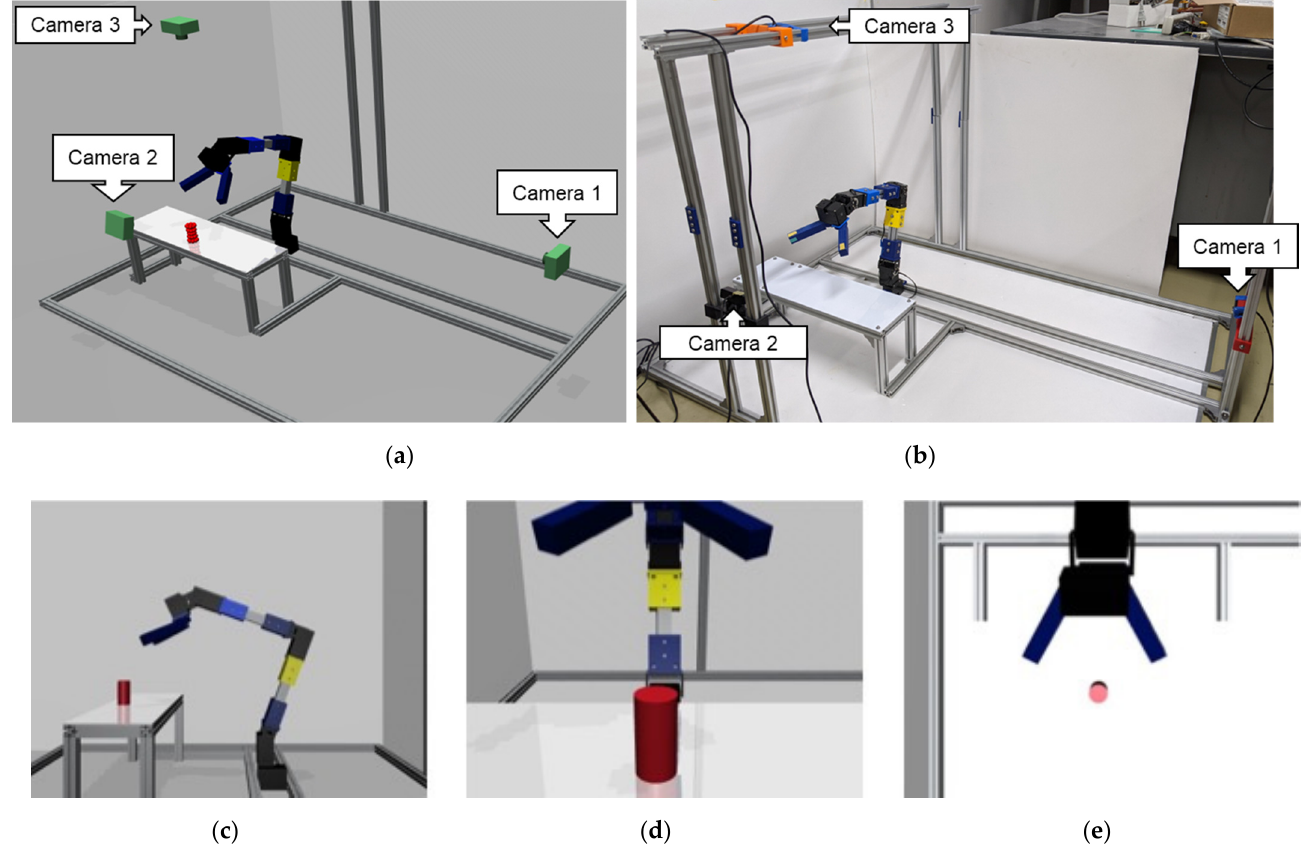
Figure 2. The proposed virtual and real workspace and corresponding camera outputs. ( a ) Virtual simulation scene. ( b ) Actual robot setup. ( c ) Camera 1 output. ( d ) Camera 2 output. ( e ) Camera 3 output.